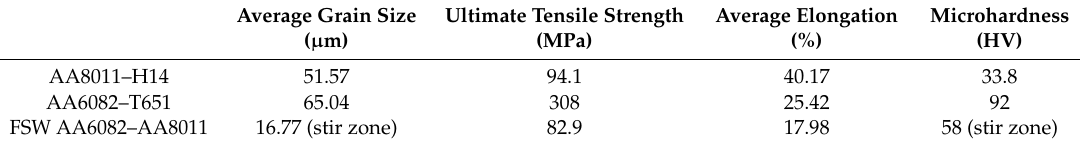
Figure 1. ( a ) Friction stir welding process, ( b ) one-pass submerged friction stir processing (SFSP) and ( c ) four-pass SFSP. Table 3. Grain size and mechanical properties of the base materials and FSW joint [17,30].